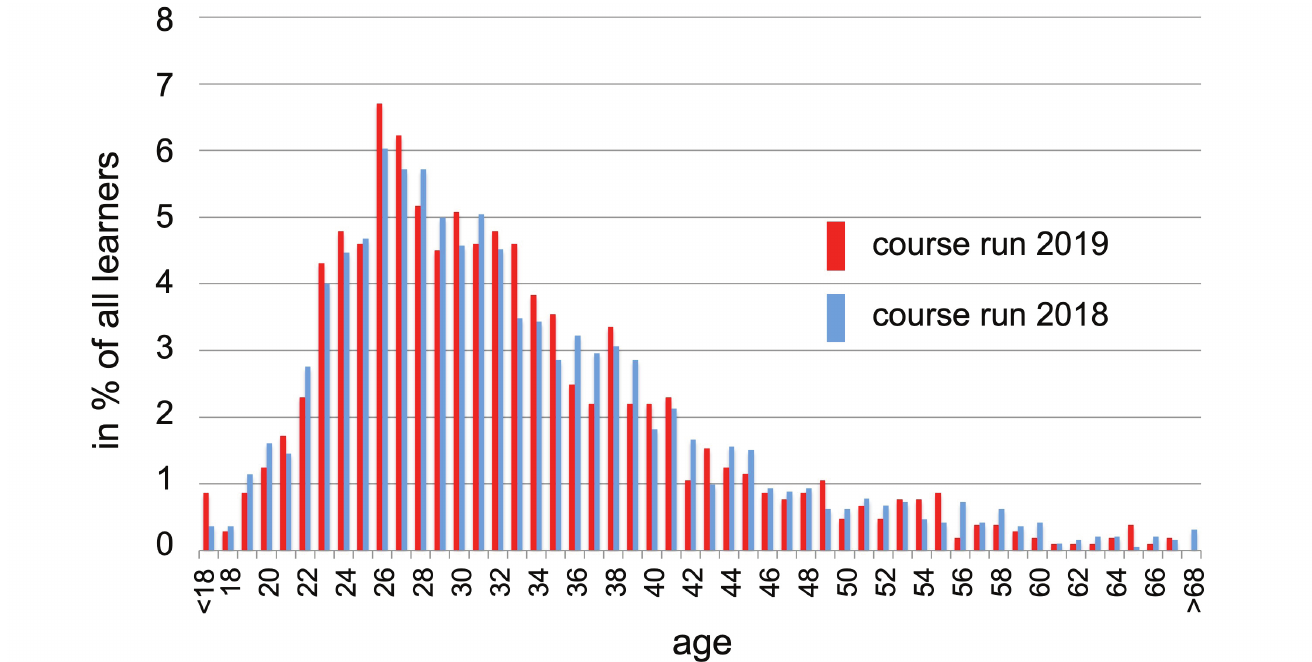
Figure 2: Age distribution of the learners in both course runs